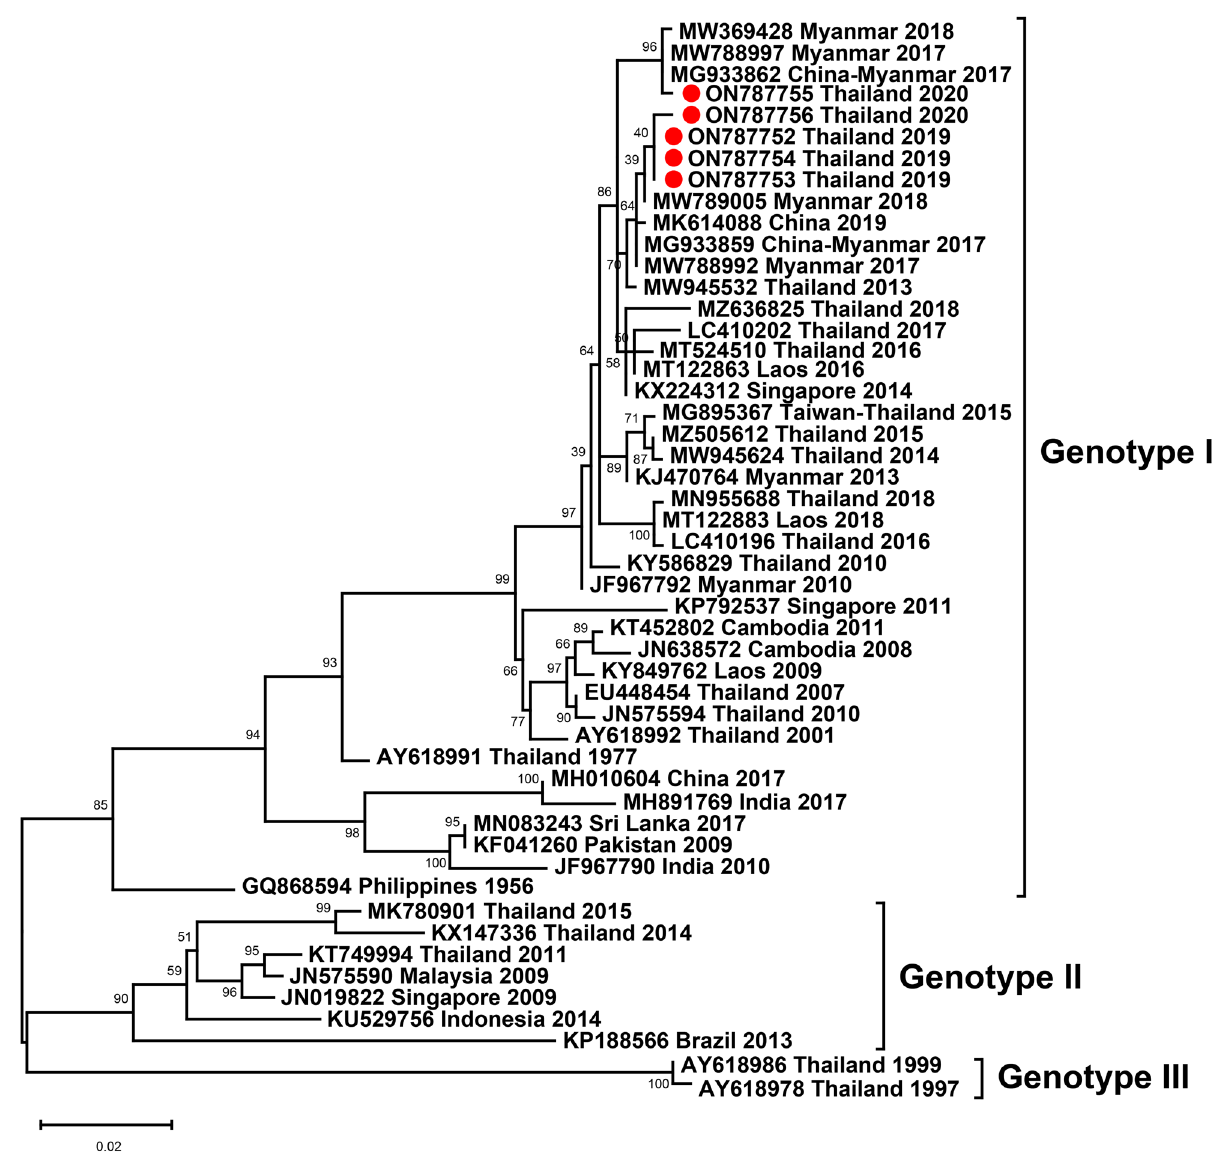
Figure 7. Phylogenetic analysis of DENV-4. The maximum-likelihood tree of DENV-4 was constructed from partial E gene sequences (724 nucleotides) of DENV-4 Thai strains isolated in this study and strains selected from the GenBank database. The tree was generated using the TIM + F + G4 model with 1000 ultrafast bootstrap replicates. Bootstrap values are indicated at branch nodes. Red dots denote DENV Thai strains from this study. Black brackets on the right indicate DENV-4